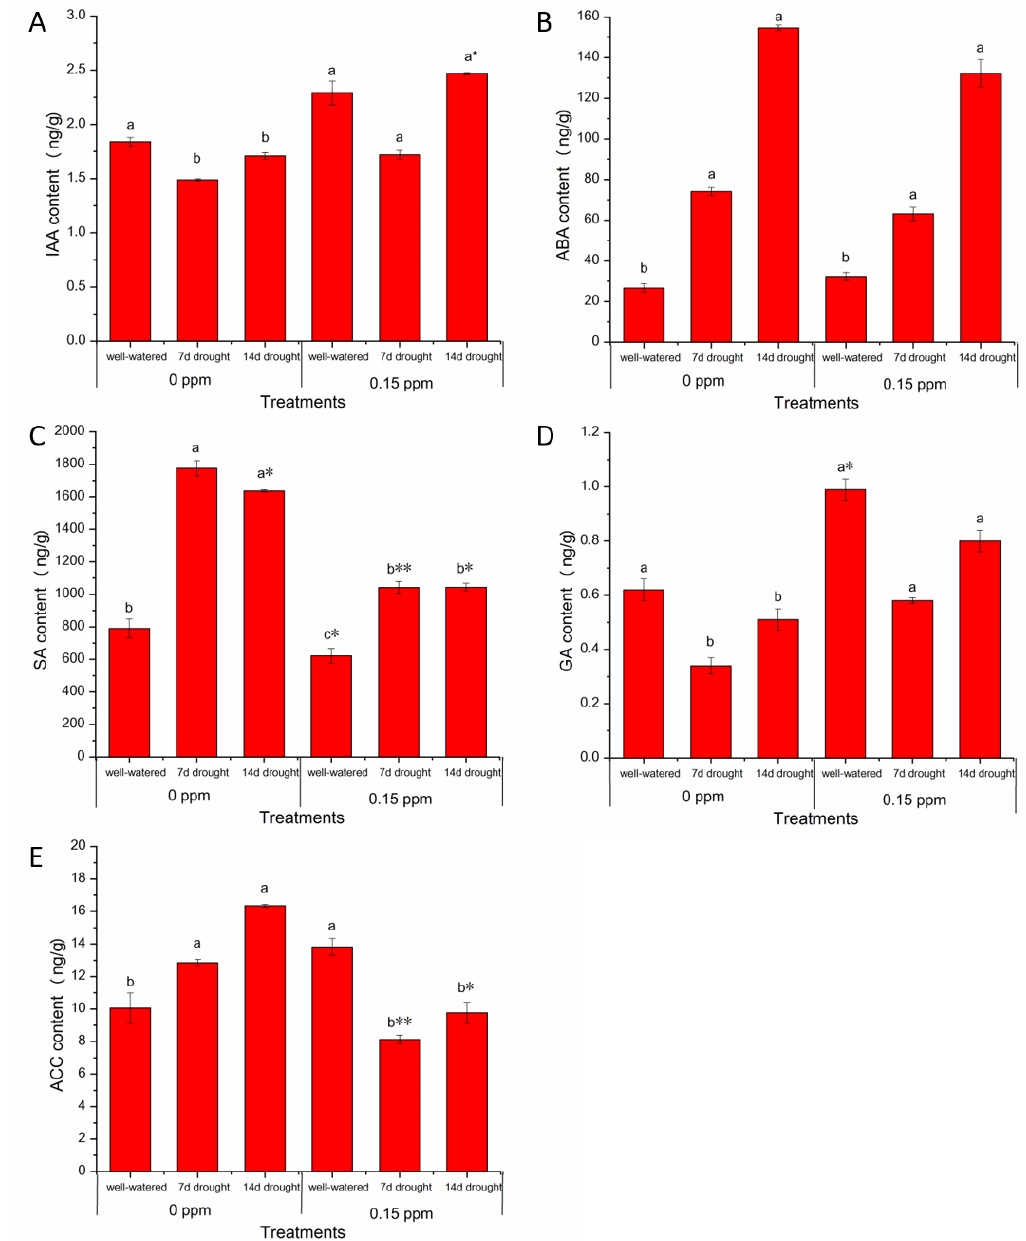
Figure 4. E ff ects of seed priming with brassinolide on hormone contents in peanut leaves under well-watered and drought conditions. ( A ) IAA content; ( B ) ABA content; ( C ) SA content; ( D ) GA content; ( E ) ACC content. Data are presented as the mean ± standard error ( n = 3). Letters above the bar represent the statistically significant di ff erence between any two conditions of well-watered, 7-d drought, and 14-d drought ( p < 0.05) as determined by the least significant di ff erence test. Asterisk * and ** represent the statistically significant di ff erence at p < 0.05 and p < 0.01, respectively, between 0.15 ppm BR priming and 0 ppm BR priming. 7 d, 7 days; 14 d, 14 days. IAA, indole-3-acetic acid; GA, gibberellin; ABA, abscisic acid; SA, salicylic acid; ACC, 1-aminocyclopropane-1-carboxylic acid as the precursor of